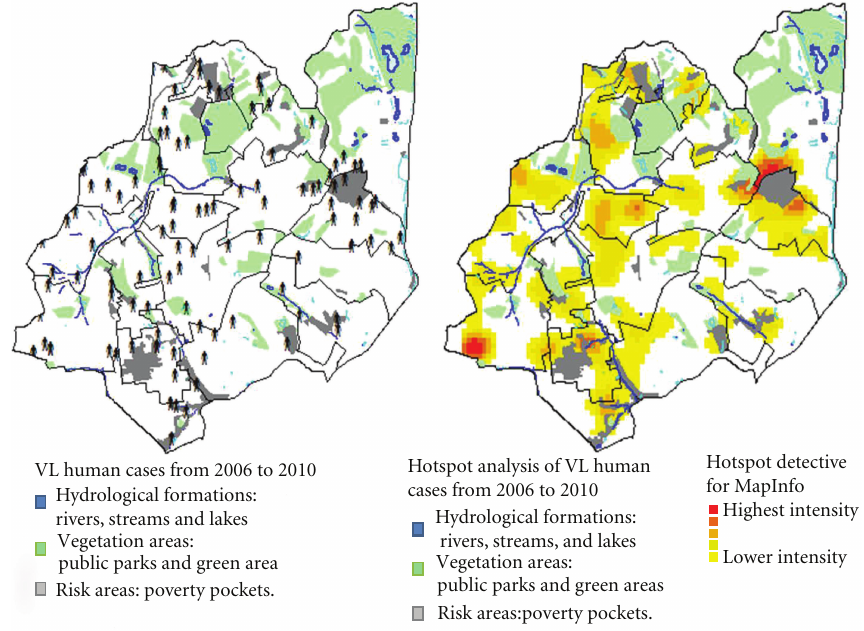
Figure 6: Map of VL human cases from 2006 to 2010 overlaying the maps of Vegetation (green areas and parks), Hydrographic (rivers, streams and lakes) and poor areas and social risk.